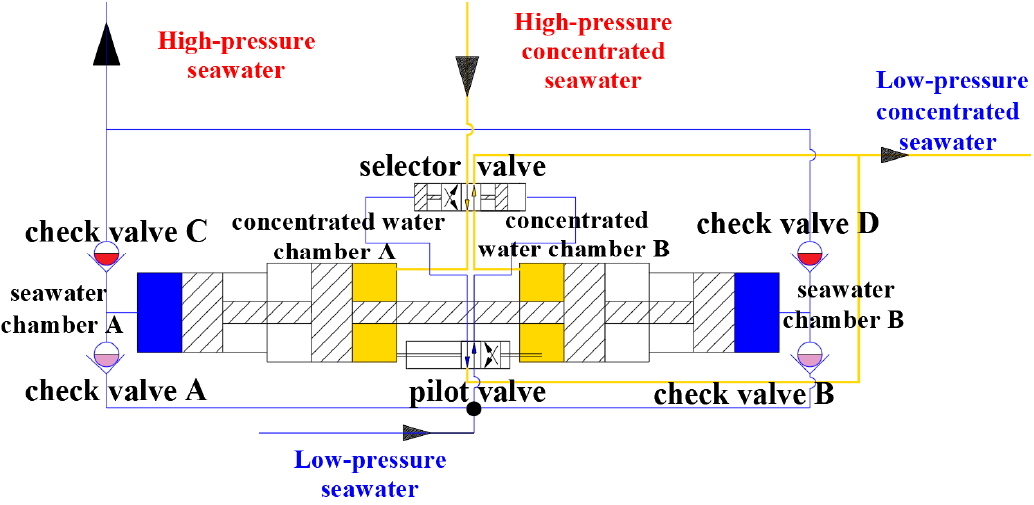
Figure 2. Schematic diagram of RO energy recovery unit.